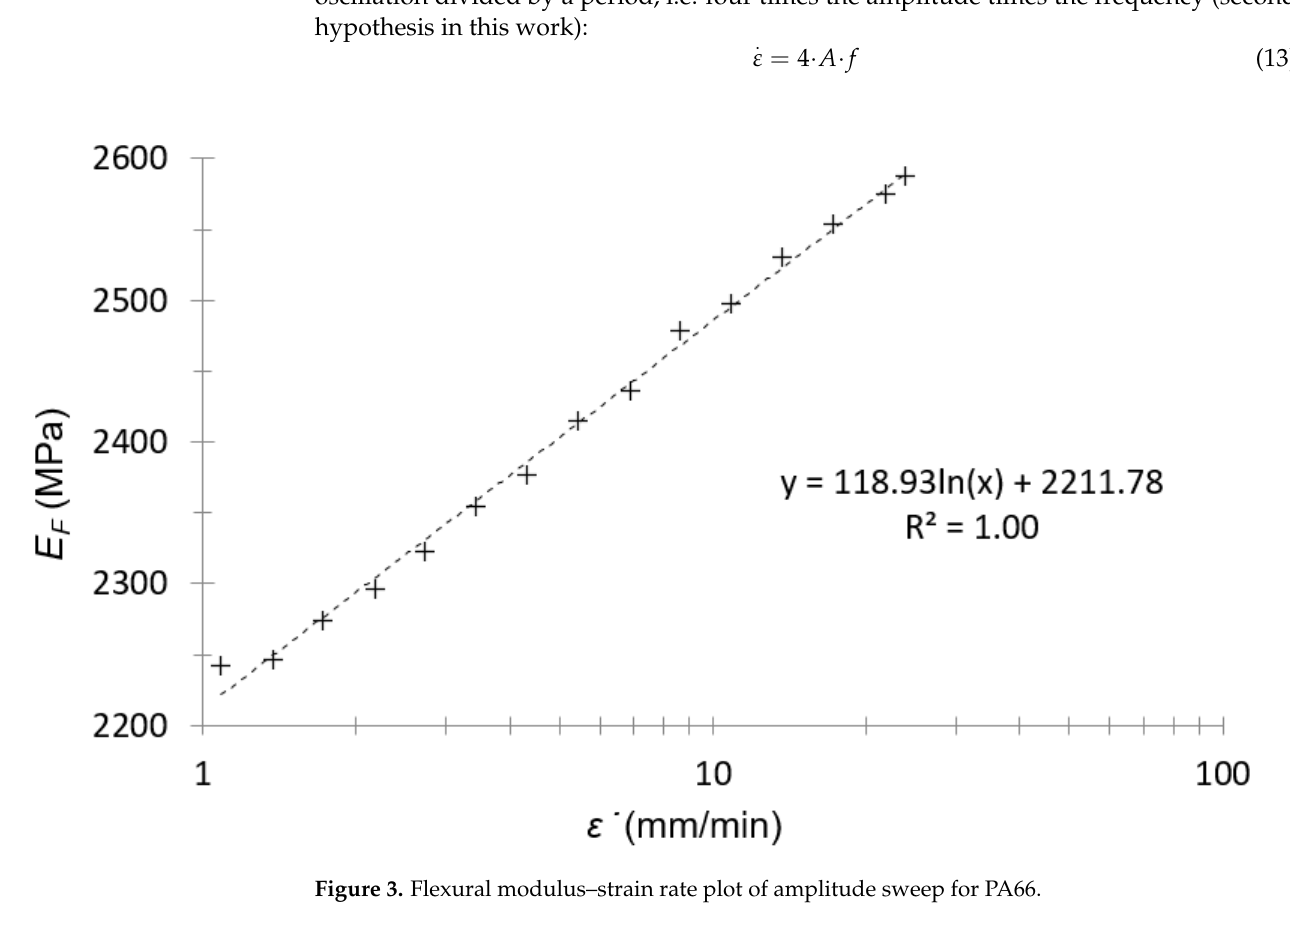
Figure 3. Flexural modulus – strain rate plot of amplitude sweep for PA66.